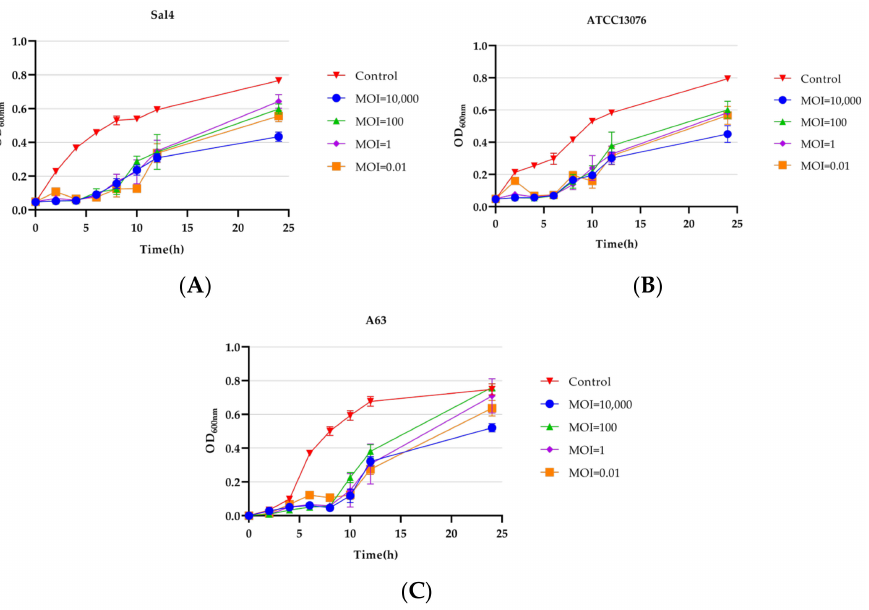
Figure 5. Phage SPJ41 inhibition of S. Typhimurium Sal4 ( A ), S. Enteritidis ATCC 13076 ( B ), and MDR S. Derby A63 ( C ).